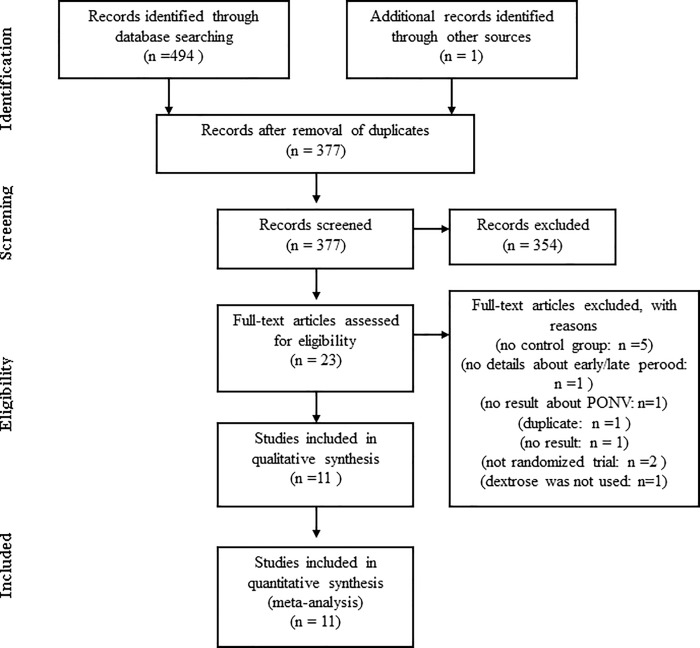
The PRISMA flow diagram for selection of studies.